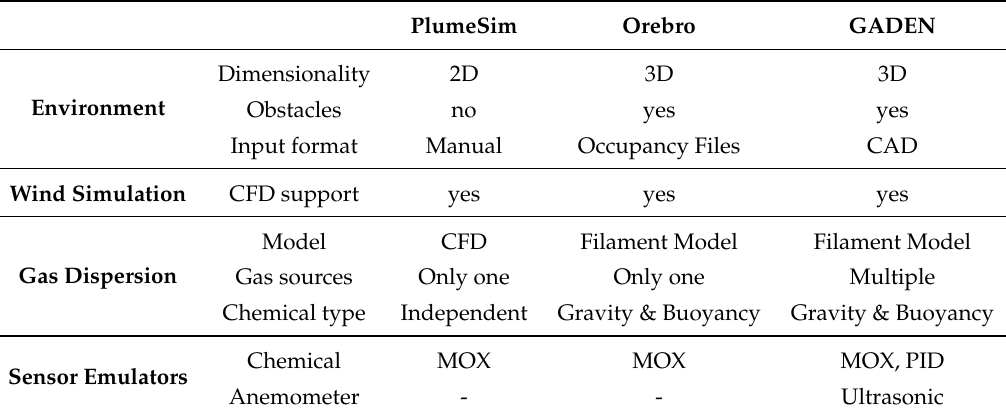
Table 1. Comparison of Gas Dispersion Simulators with ROS support. In the table, MOX stands for Metal Oxide Sensors, PID stands for Photo Ionization Detectors, CAD stands for Computer Aided Design while CFD stands for Computational Fluid